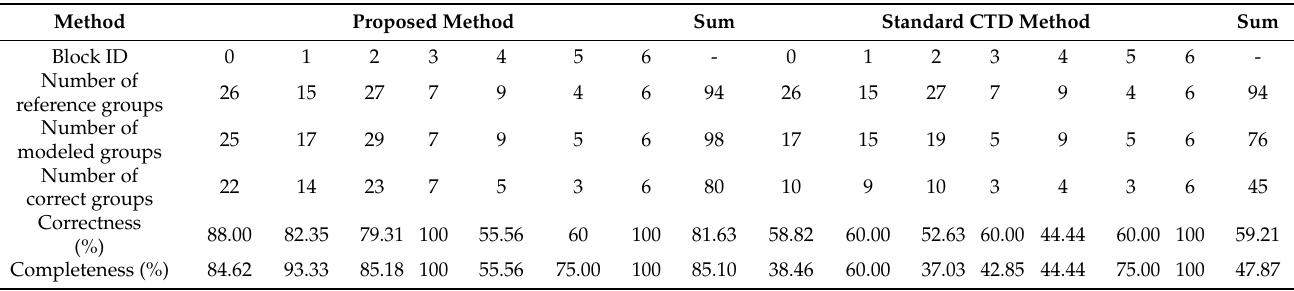
Table 2. The accuracy of building pattern recognition.